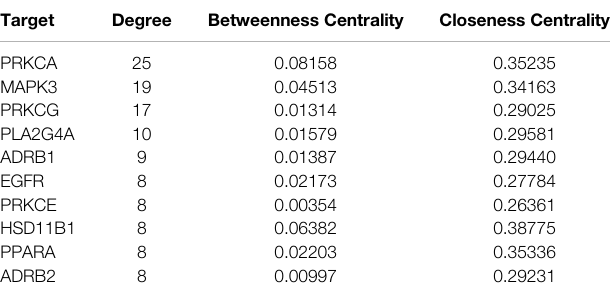
TABLE 5 | Putative targets of XML injection in the prevention of myocardial